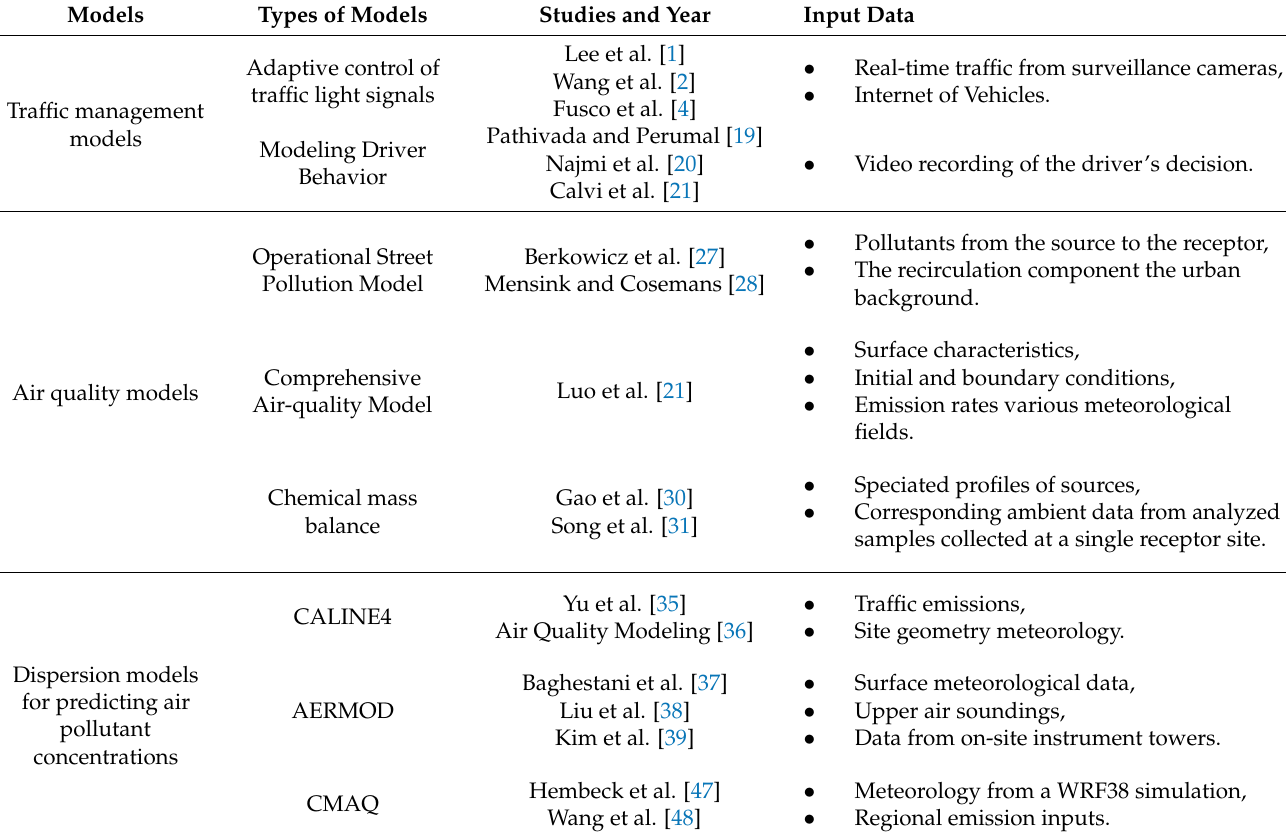
Table 1. Classification of studies by emissions from